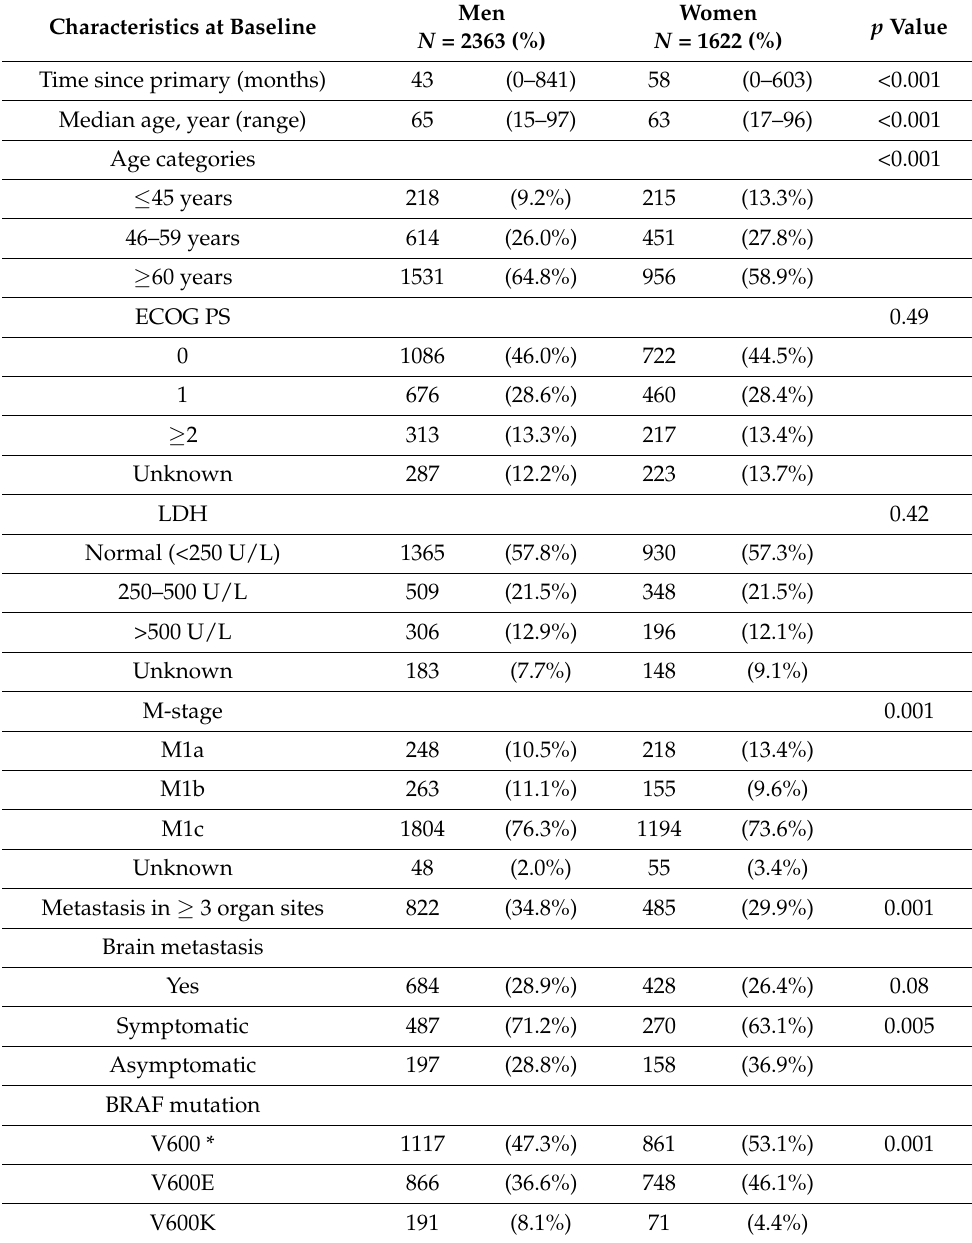
Table 1. Clinical and tumor characteristics of advanced cutaneous melanoma